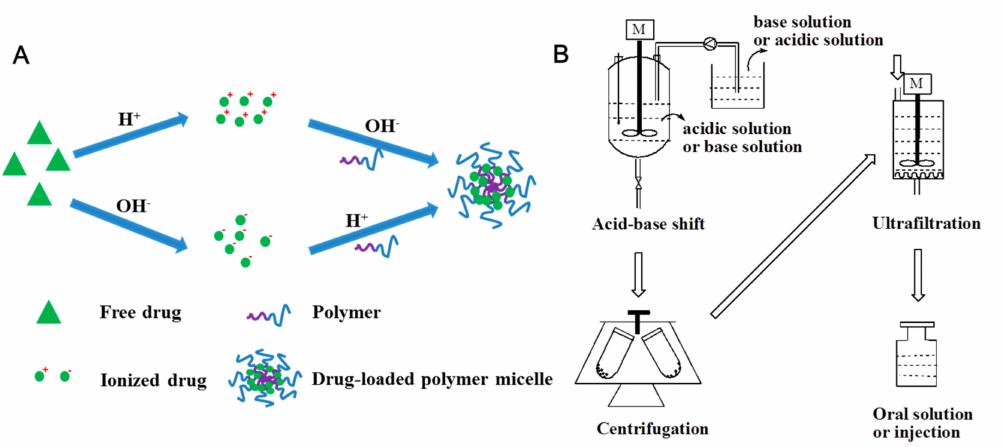
ABS, acid-base shift.